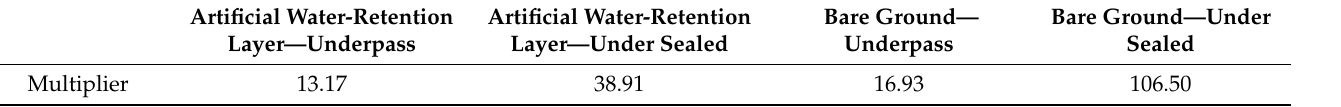
Table 2. Ratio of total evaporation to total condensation for each type of test